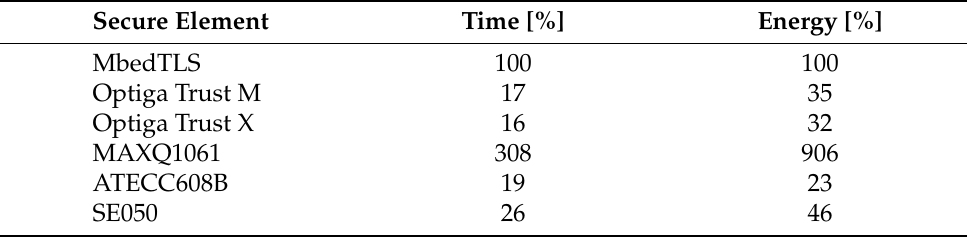
Figure 8. Time and energy measured for generating an ECC key pair relative to the reference implementation. (median of values, rounded to the nearest percent, n = 100). Table 2. Table of values for Figure